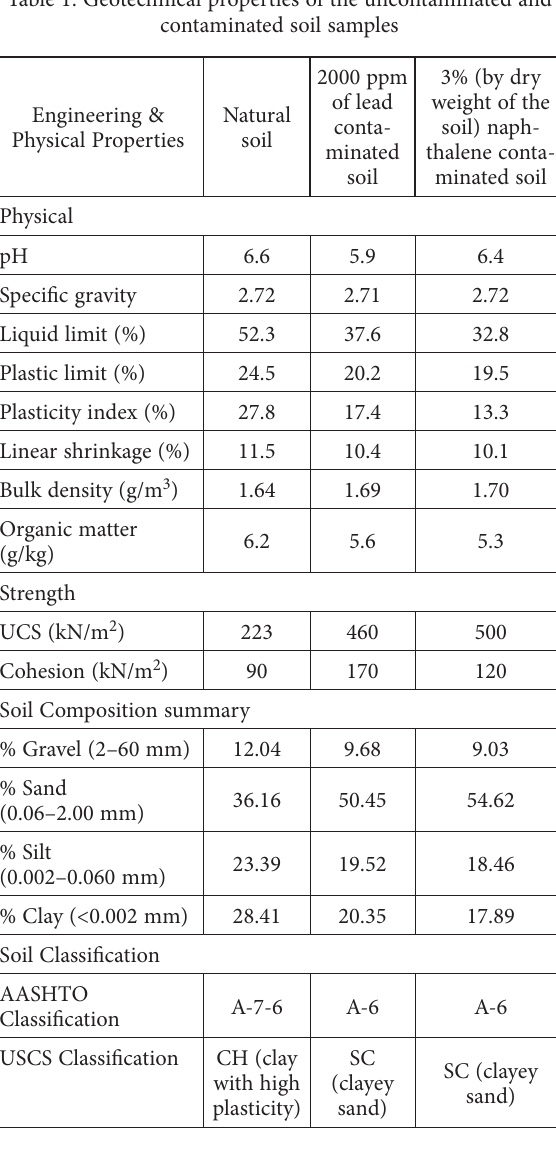
Figure 1. Chemical composition of soil and cement